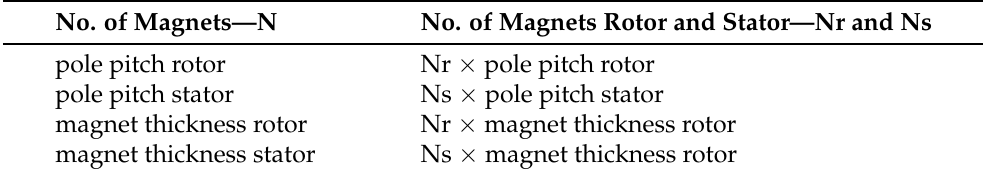
Table 1. Extended parameter space-breaking design symmetry.